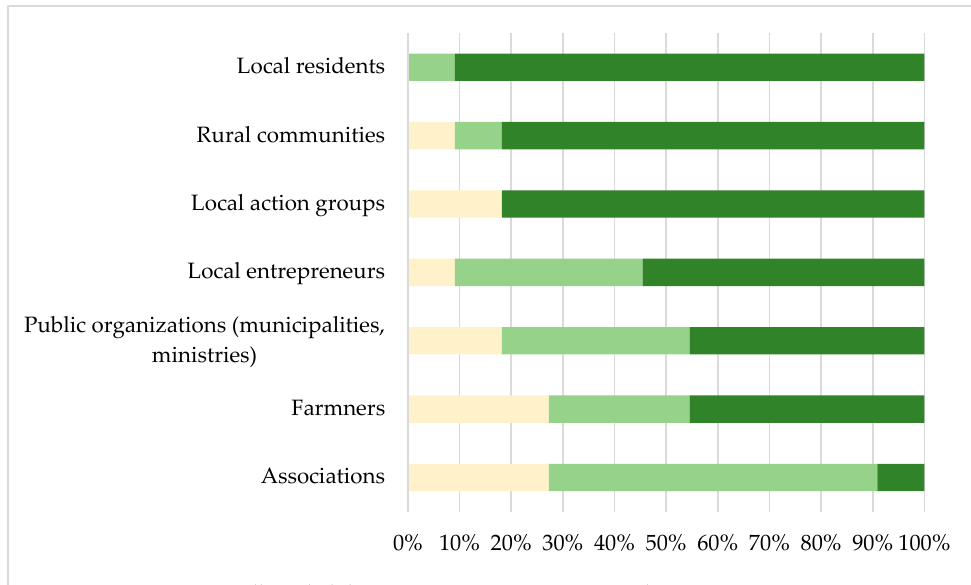
Figure 1. The importance of Lithuanian rural actors for rural development. Source: created by authors, based on research results.